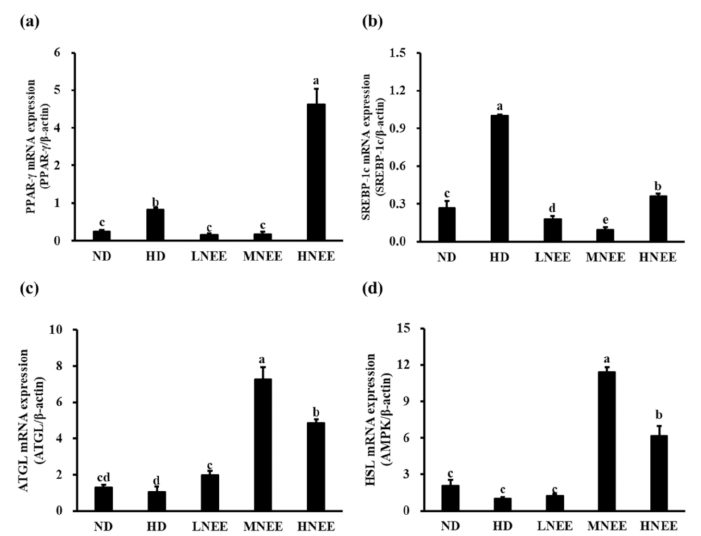
Figure 7. Effects of NEE on mRNA expression of adipogenesis and lipid lysis-related gene in epididymal adipose tissue of high calorie diet–induced obese rats. Quantitative real-time PCR was used to evaluate the mRNA expression of PPAR- γ ( a ), SREBP-1c ( b ), ATGL ( c ), and HSL ( d ). Duncan’s test was used to assess the significance of differences in mRNA expression of adipogenesis and lipid lysis-related genes. The data are the means and standard deviations ( n = 5). Different letters (a–e) denote statistically significant differences in mRNA expression ( p < 0.05). The group names are defined in Table 2 legend.